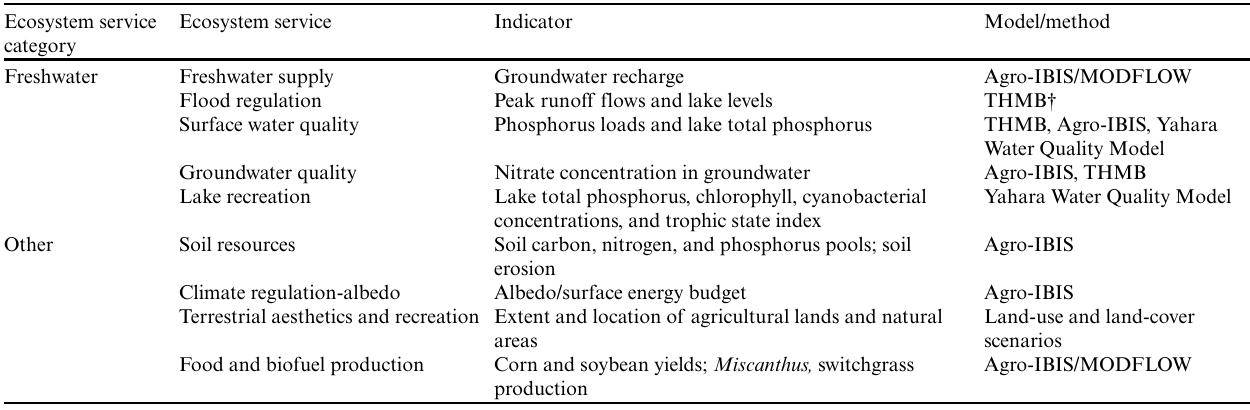
Table 1. Freshwater and other ecosystem services studied.